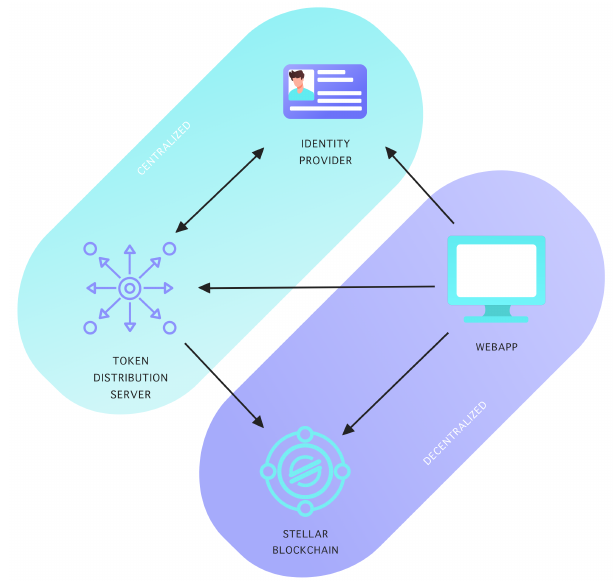
Figure 4. Centralized and decentralized parts of the